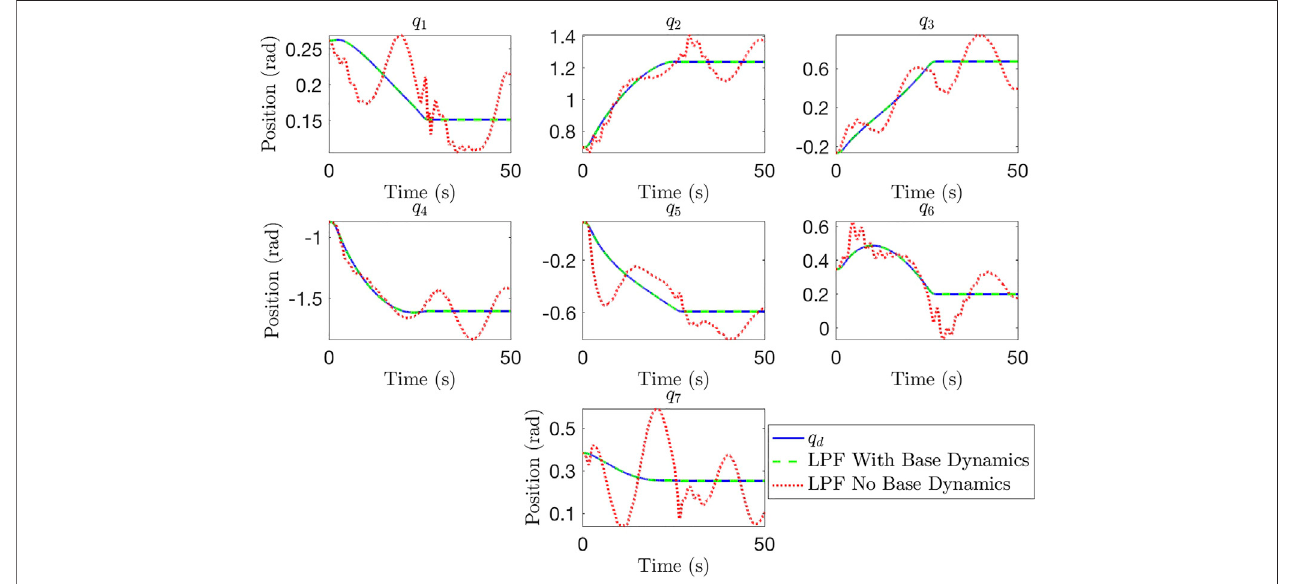
FIGURE 6 | Comparison of joint space performance with uncontrolled fl oating base when base dynamics are and are not accounted for.